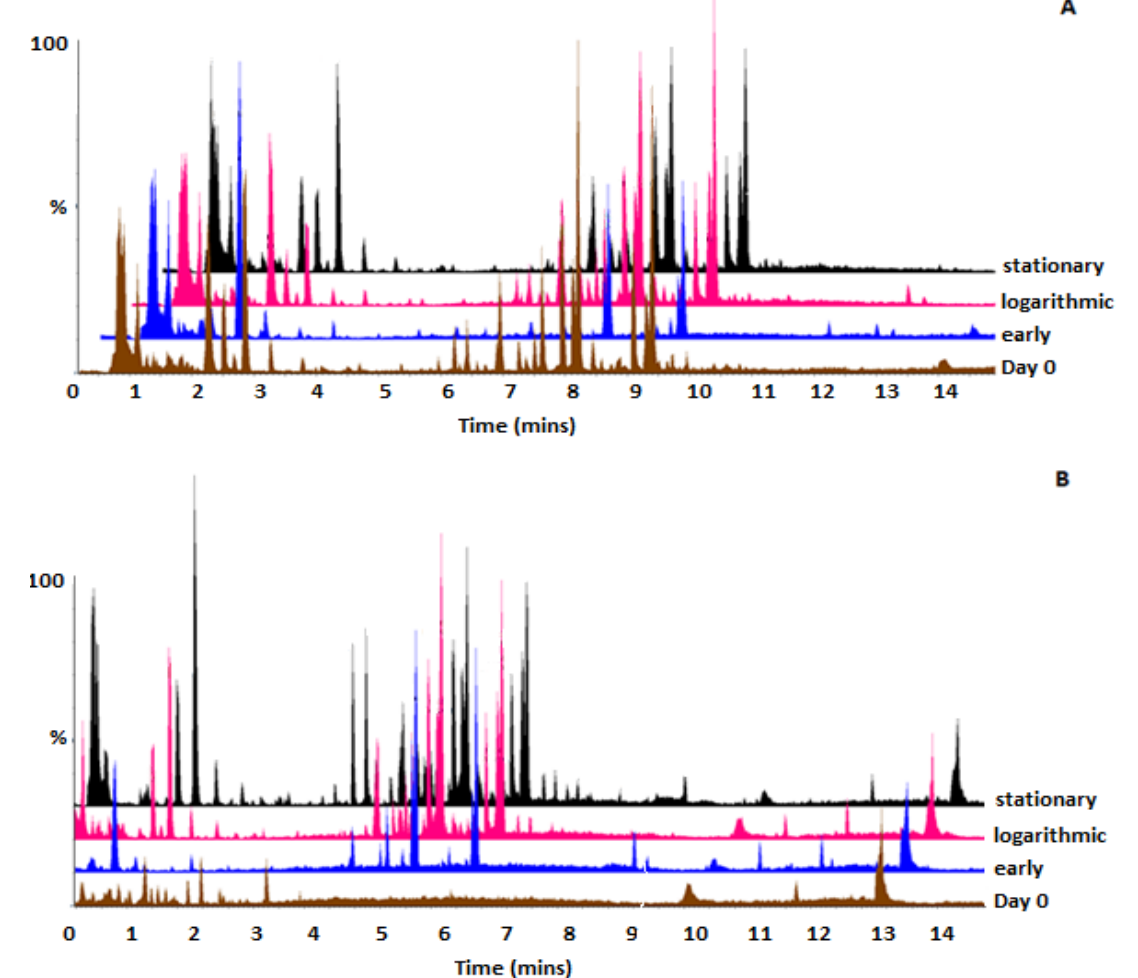
Figure 1. Ultra-high performance liquid chromatography (UHPLC) separation with high-definition mass spectrometry (HD–MS) detection in electrospray ionization (ESI) negative mode of ( A ) methanolic- and ( B ) and acetonic cellular extracts of Hyphozyma roseonigra. Cells were harvested from selected days over a 14 d period representing the different growth stages, i.e., early, logarithmic and stationary. The representative base peak intensity (BPI—the most intense peaks at a specific retention time) chromatograms show evident differential peak populations across the different days. The X -axes are staggered across the retention time scale and the Y -axes linked to allow comparison of peak intensities.